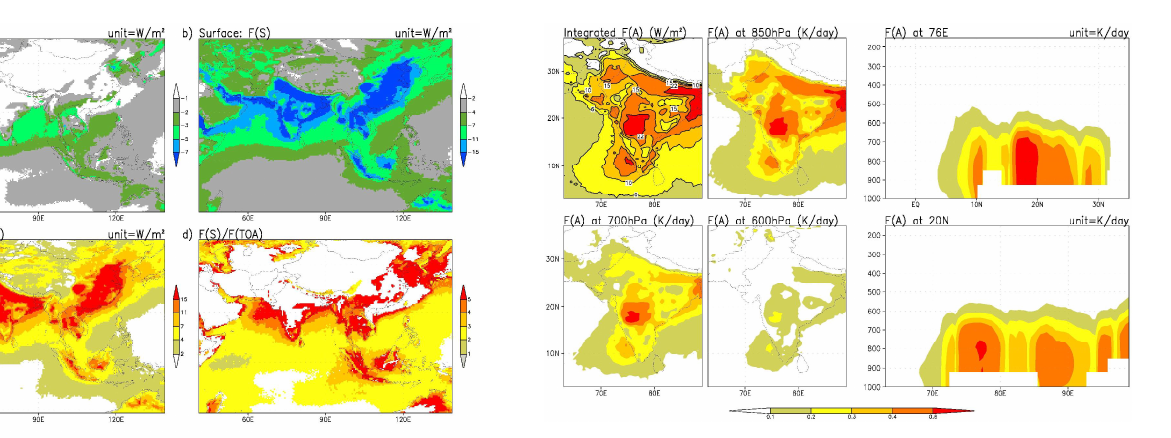
Figure 10. Anthropogenic aerosol forcing in the atmosphere for February (averaged from 2001 to 2004).